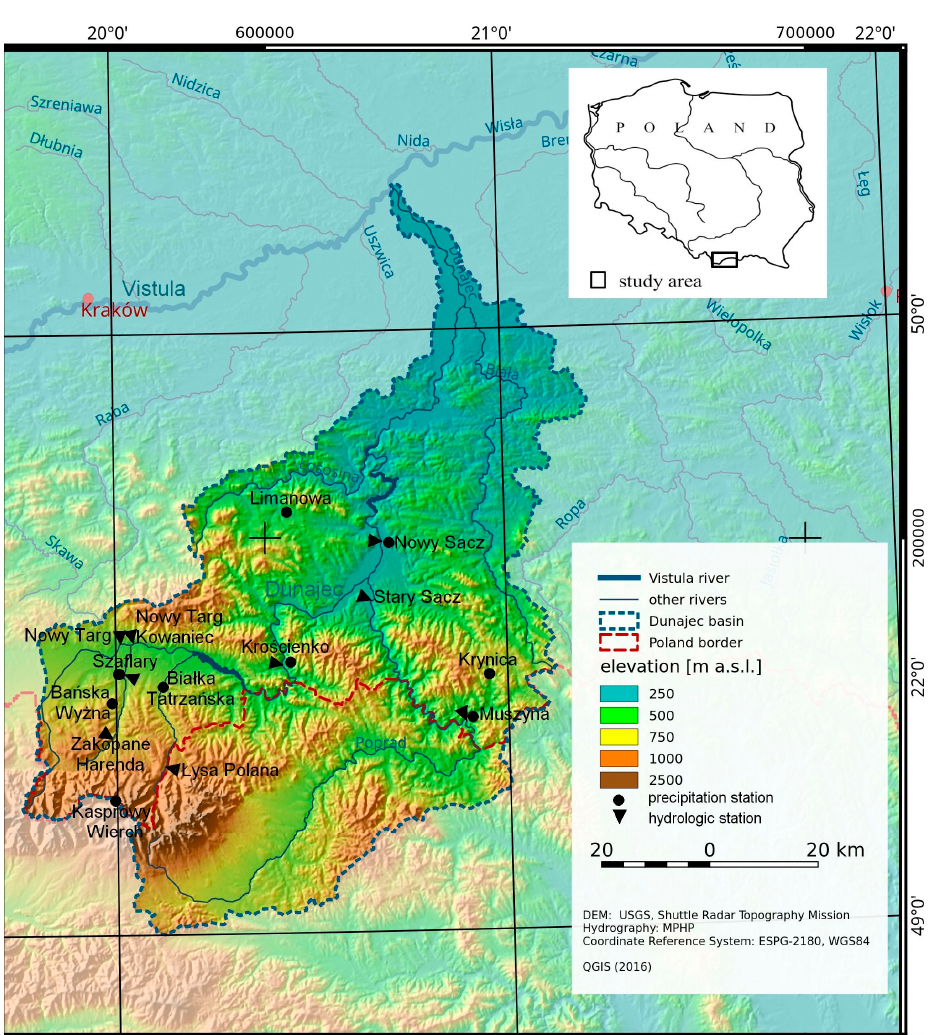
Figure 1. Study area—the Dunajec catchment with observation stations used.